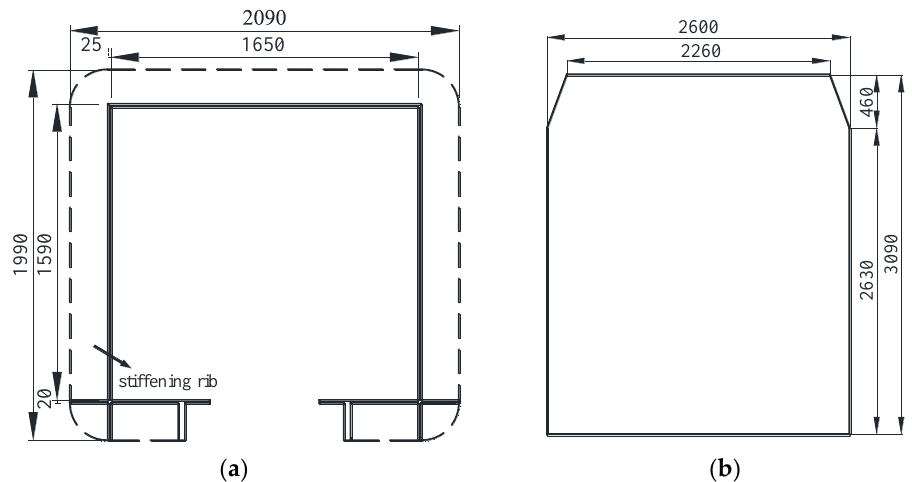
Figure 2. Dimensions of the cross-section: ( a ) Bridge; ( b ) Vehicle (unit: mm).